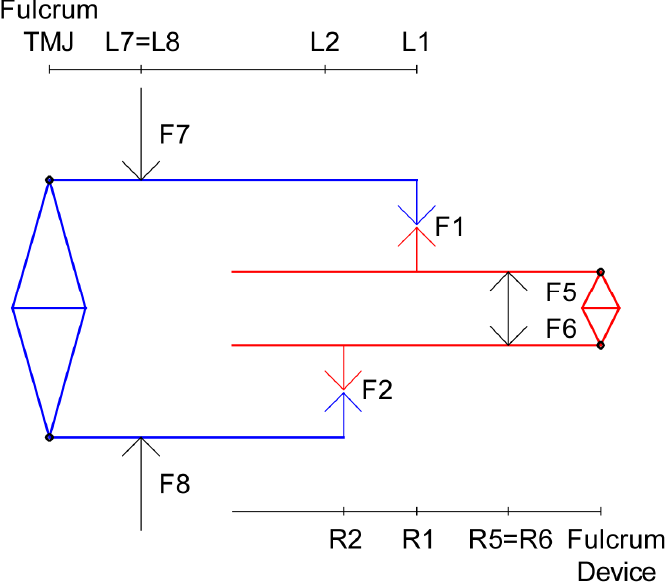
Figure A8. Representation of the masticatory system and the device with only one application point for each dental arc.